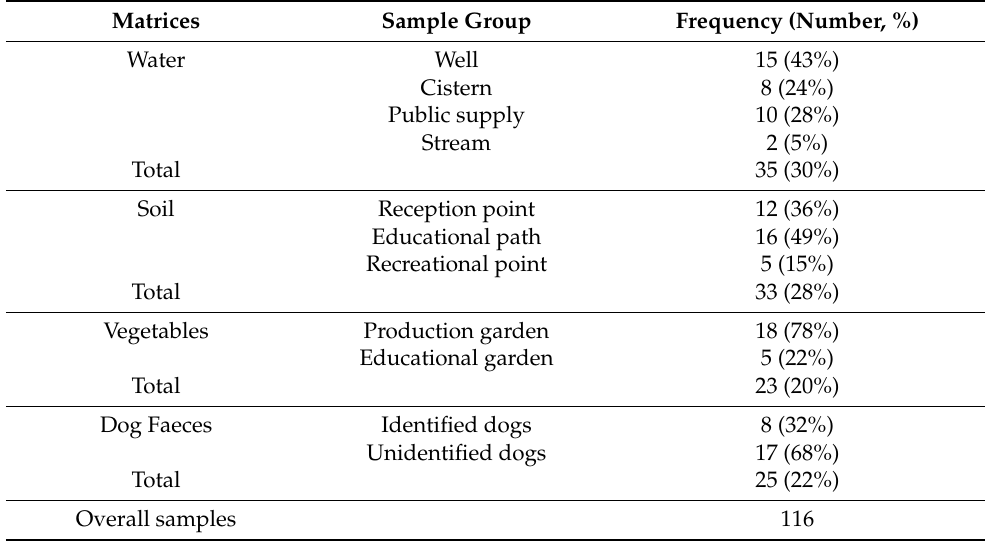
Table 1. Samples distribution by matrices and place. Matrices Sample